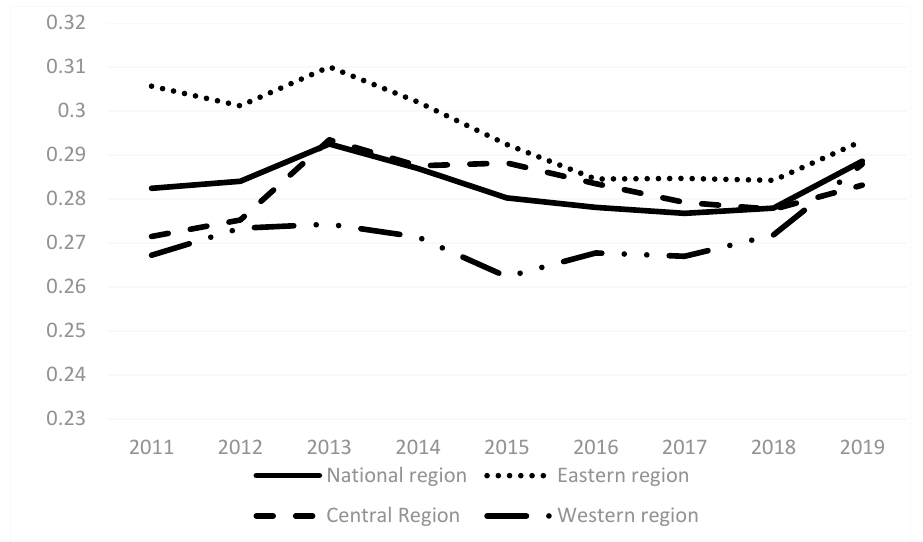
Figure 1. Evolution trend of agricultural multifunctionality extension in China from 2011 to 2019. Table 4. Average values of agricultural multifunctionality, and subdivision indices of 30 sample provinces in China from 2011 to 2019.